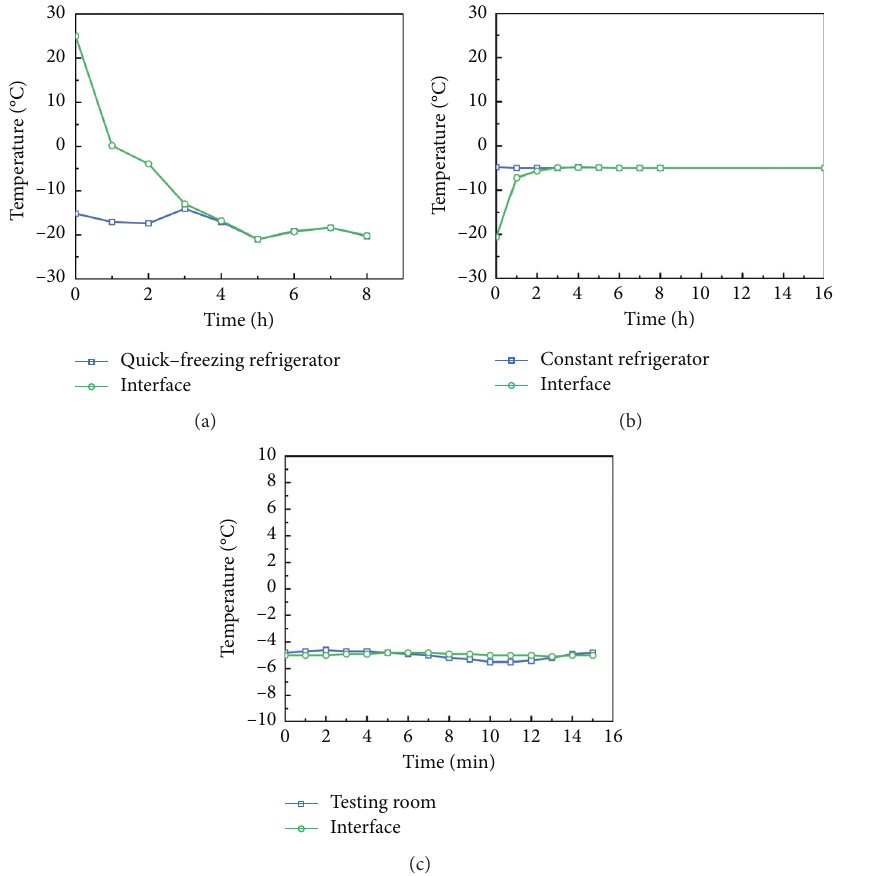
Figure 2: Temperature variations during quick-freezing (a), constant temperature process (b), and shearing test